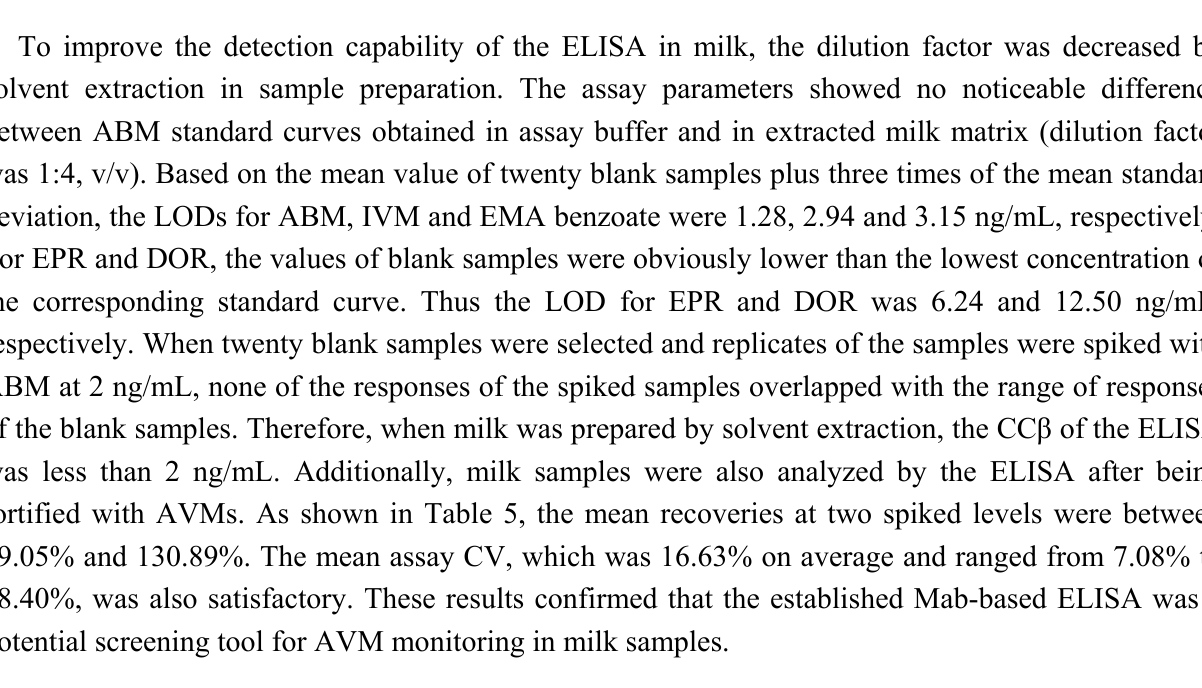
Table 5. Recoveries of AVMs from spiked milk samples with solvent extraction (n =